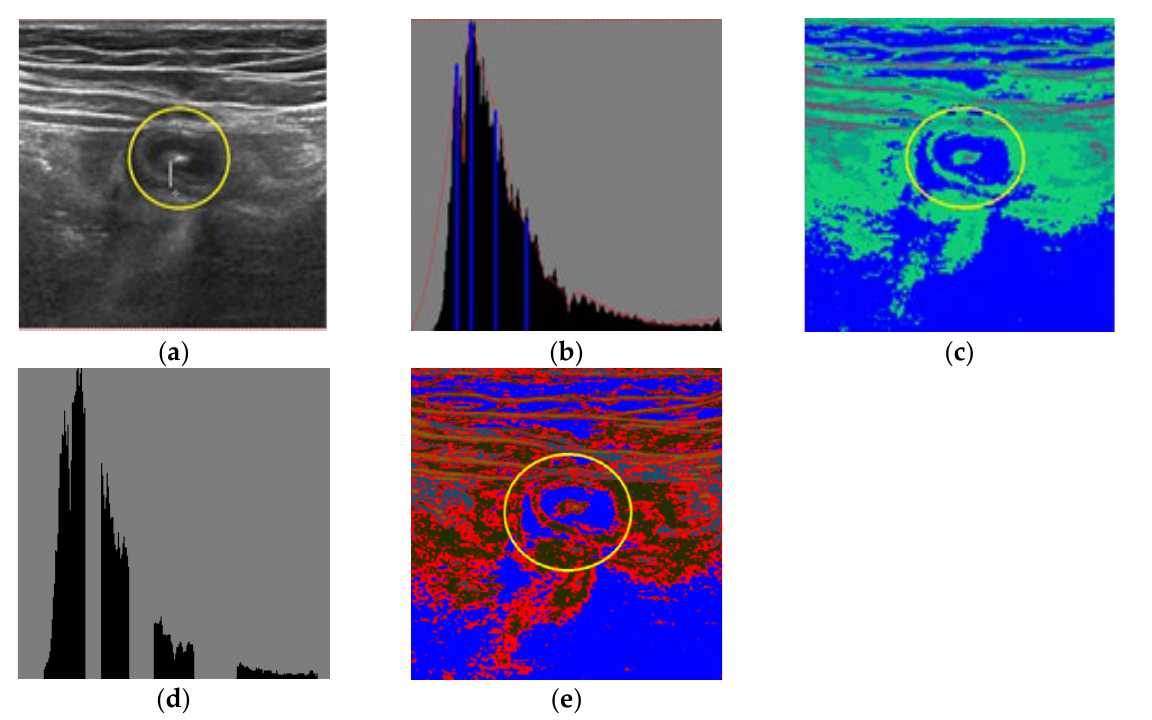
Figure 7. Effect of double layered learning structure. ( a ) Input, ( b ) Layer-1 histogram, ( c ) ORFCM result, ( d ) Layer-2 histogram, and ( e ) DORFCM result.